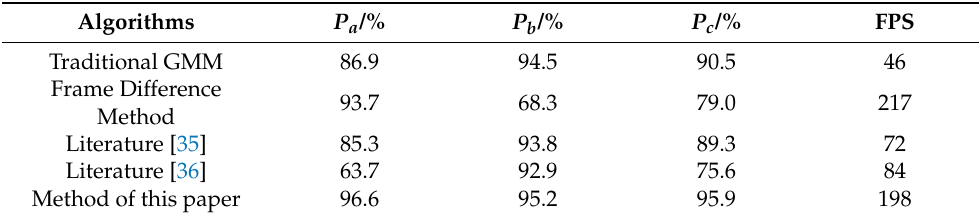
Table 2. Comparison of detection performance based on image processing algorithms. Algorithms a P /% Traditional GMM